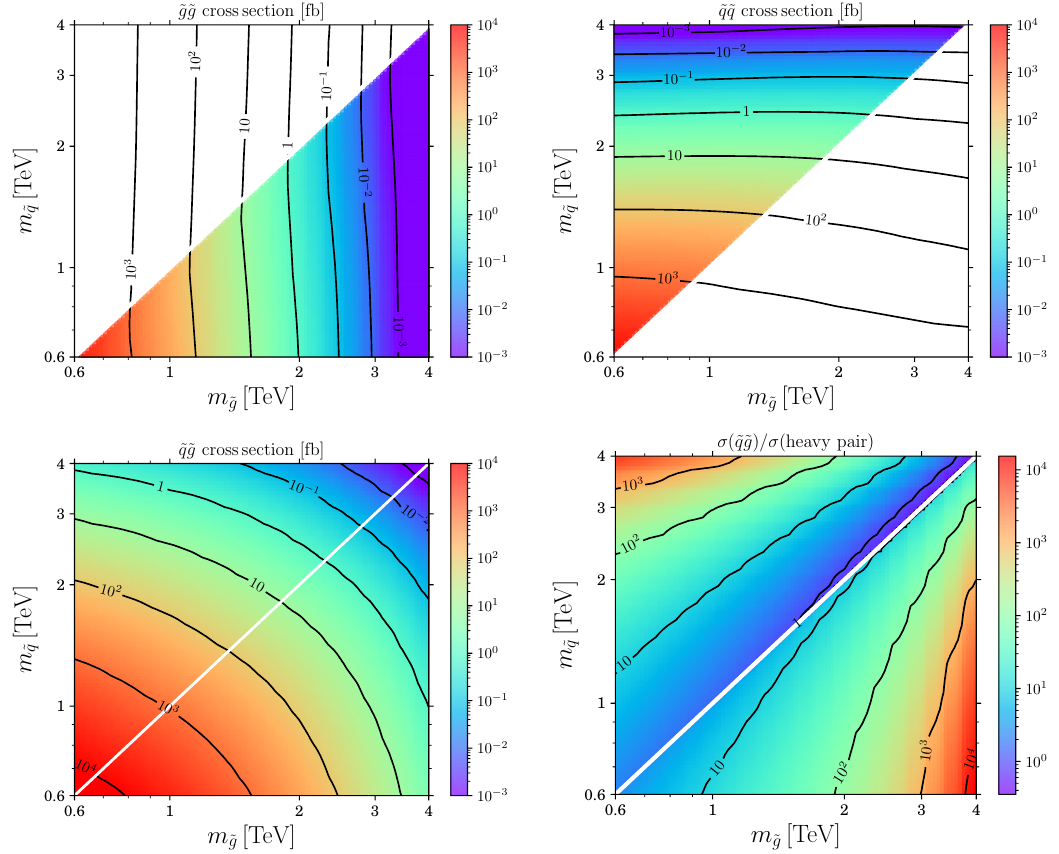
Figure 8 . NLO cross sections of various production modes (and their ratios) of gluinos and squarks at the 13 TeV LHC are presented in the ( m ˜ g , m ˜ q ) plane in fb. In the top panels, the gluino-gluino (left) and squark-squark (right) pair production cross sections are shown. In the top left plot, we q ˜ q , highlight the m ˜ g > m ˜ q region, for which the pp ˜ g ˜ g production results in high p T jets from ˜ g → → even if the lightest neutralino is mass degenerate with the lightest coloured particle. Analogously, in the top right plot we highlight the m ˜ q > m ˜ g region, for which the same final state originates the pp q ˜ g decays. The bottom left panel is for the associated squark- ˜ q ˜ q process, followed by the ˜ q → → gluino production. The bottom right panel shows the relative rate of the associated squark-gluino production cross section with respect to the gluino-gluino (in the lower right half with m ˜ g > m ˜ q ) and squark-squark (in the upper left half with m ˜ q > m ˜ g ) pair productions cross section,